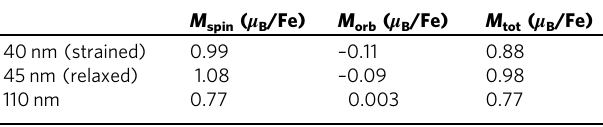
Table 1 Magnetic moments estimated by XMCD sum